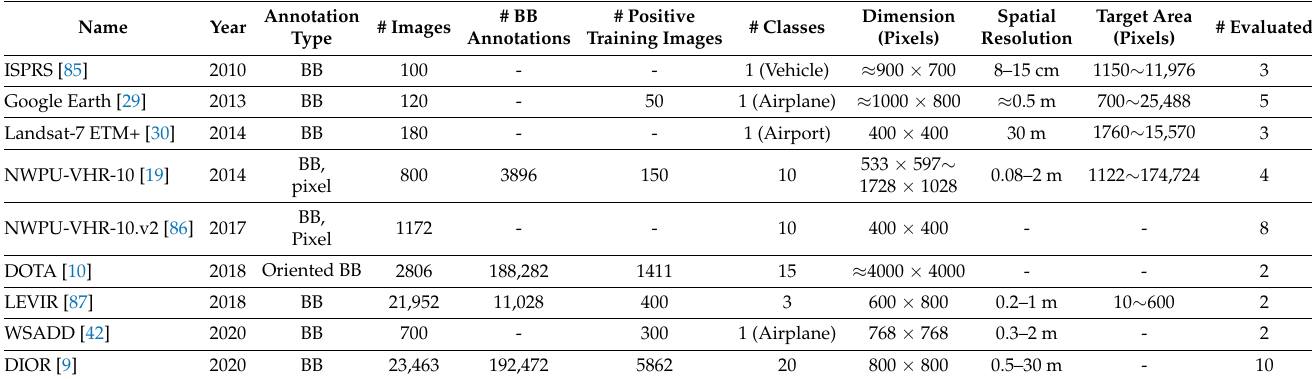
Table 2. Summary of the most common RSI datasets. For each dataset, we report the annotation type, number of images, number of BB annotations, number of positive training images (for WSOD tasks), number of classes, image characteristics, and number of times the dataset has been used for the evaluation of RSWSOD